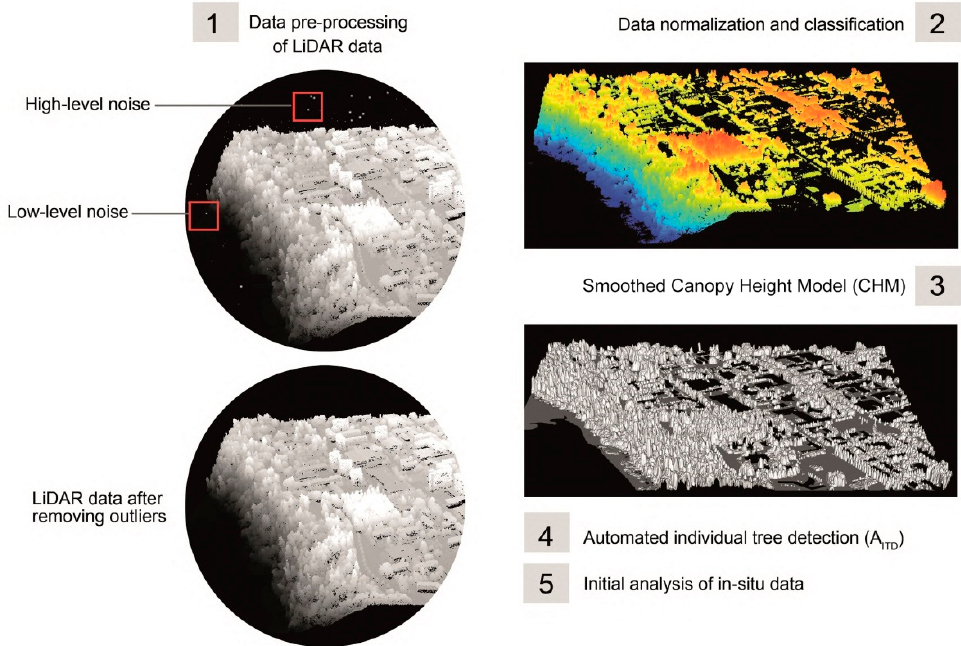
Figure 3. Methodological framework (generated in LiDAR360 v4.0 by GreenValley International and R ‐ lidR package).